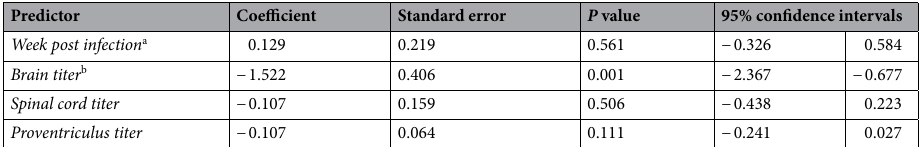
Table 3. Multivariable linear regression analysis using the brain pathology score as the dependent variable, and virus RNA copies in selected tissues and week post infection as independent variables, as assessed in a cohort of Muscovy ducks infected with aquatic bird bornavirus (ABBV)-1 delivered intracranially. a Only 4, 8 and 12 week post infection were evaluated in the analysis. b Titer in tissues is expressed as log10 of virus RNA copies per 150 ng of tissue RNA.